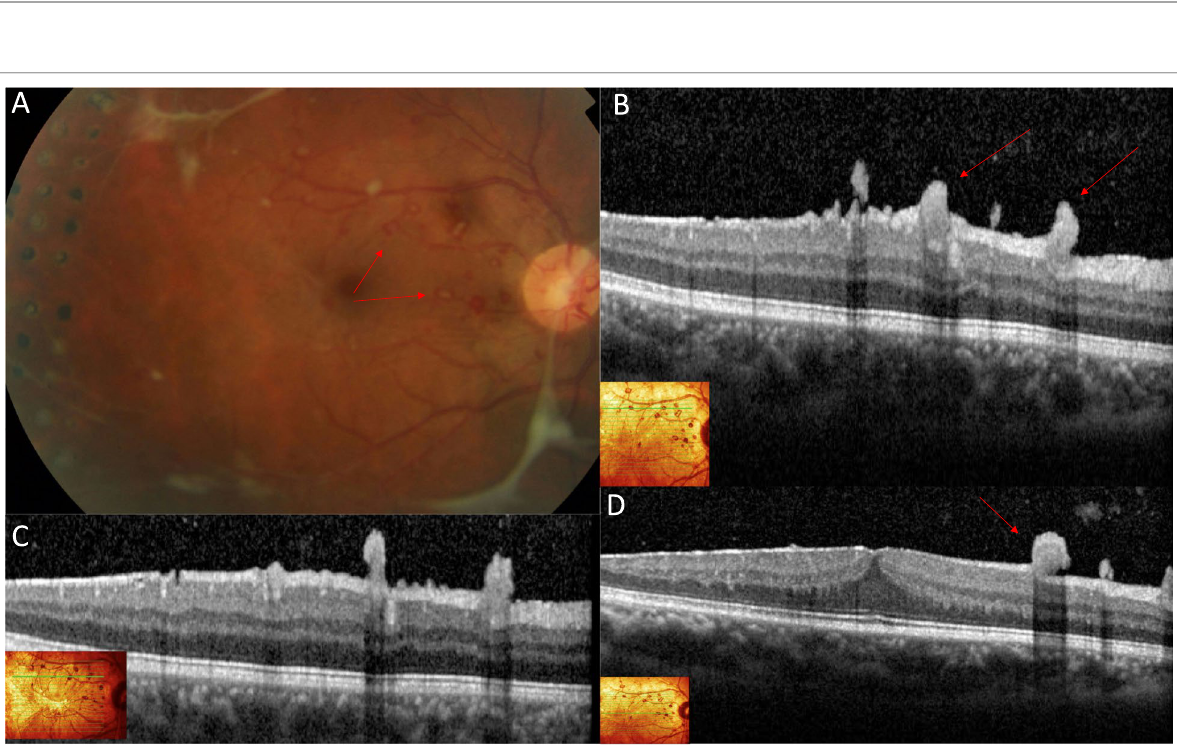
Fig. 2 Colour fundus image ( A ) of the right eye showing multiple tiny vascular tufts on the macula (Red arrows) representing ERN. Right macular OCT at different cuts ( B , C , D ) shows the ERN as multiple hyperreflective lesions breaching the ILM and extending towards the vitreous (Red